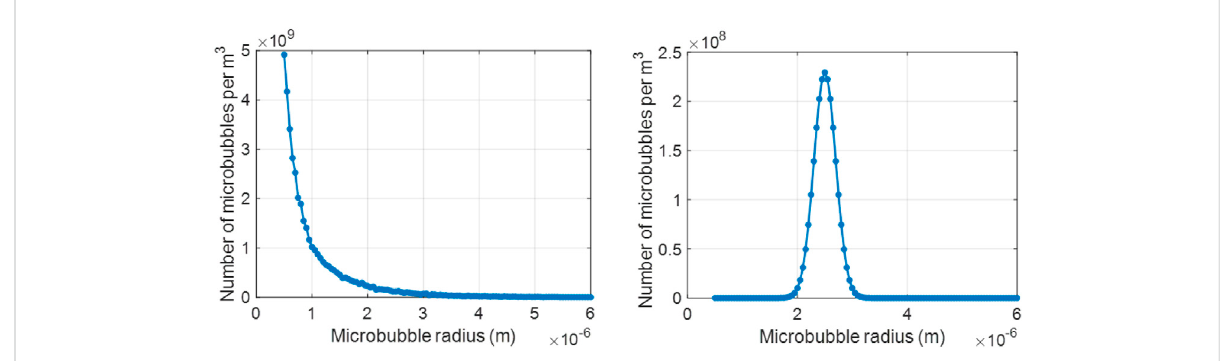
FIGURE 1 Size distribution of the UCAs used in the current work: (left) commercially available polydisperse agent, SonoVue and (right) research-grade monodisperse agent,